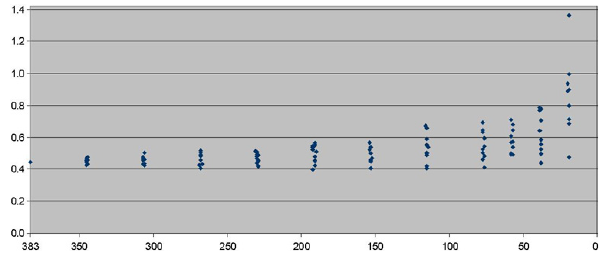
Figure 2. Minimum Temperature, April 2007 – Estimated root- mean-square errors ( ◦ C) at a subset of 20 independent points, as a function of the number of stations remaining out of the original 403 available (ten runs were made for each proportion of stations removed).